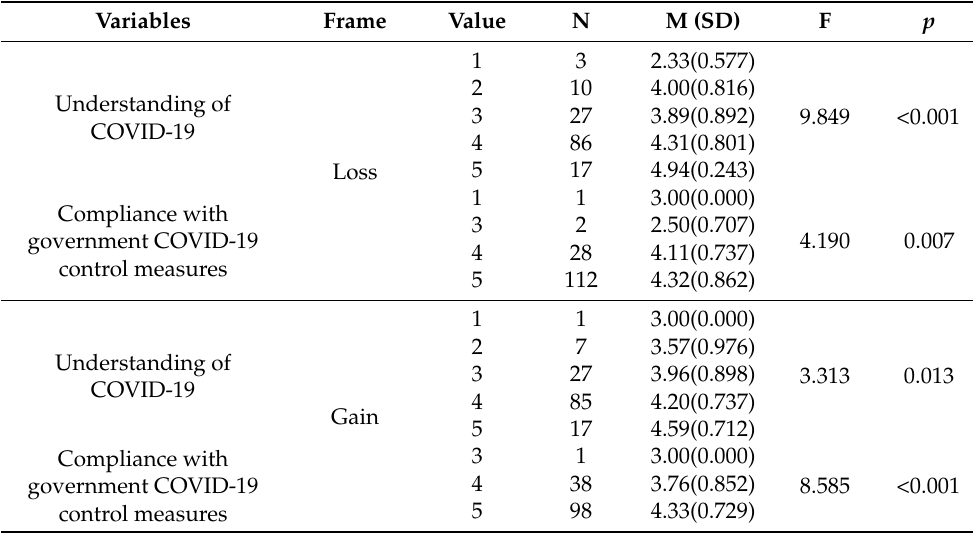
Table 3. Effect of individual awareness on vaccination intention.